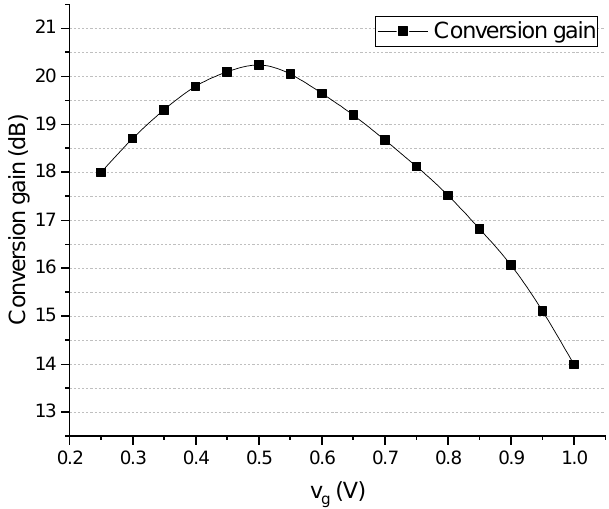
Figure 16. Simulation results of conversion gain A v . Figure 17 shows the simulated timing waveforms of proposed envelope detector. V in + and V in − are the differential input signals, which have a 915 MHz carrier frequency with 2 Mbps AM modulated signal, 0.05 modulation index, and 1 V amplitude. V G is the adaptive biasing voltage of the proposed envelope detector and V O is the envelope detector output. The amplitude of V O increases as V G settling to 1.7 V, which indicates the effectiveness of the proposed adaptive biasing